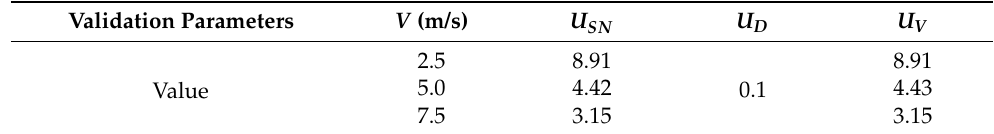
Table 6. Results for validation study.